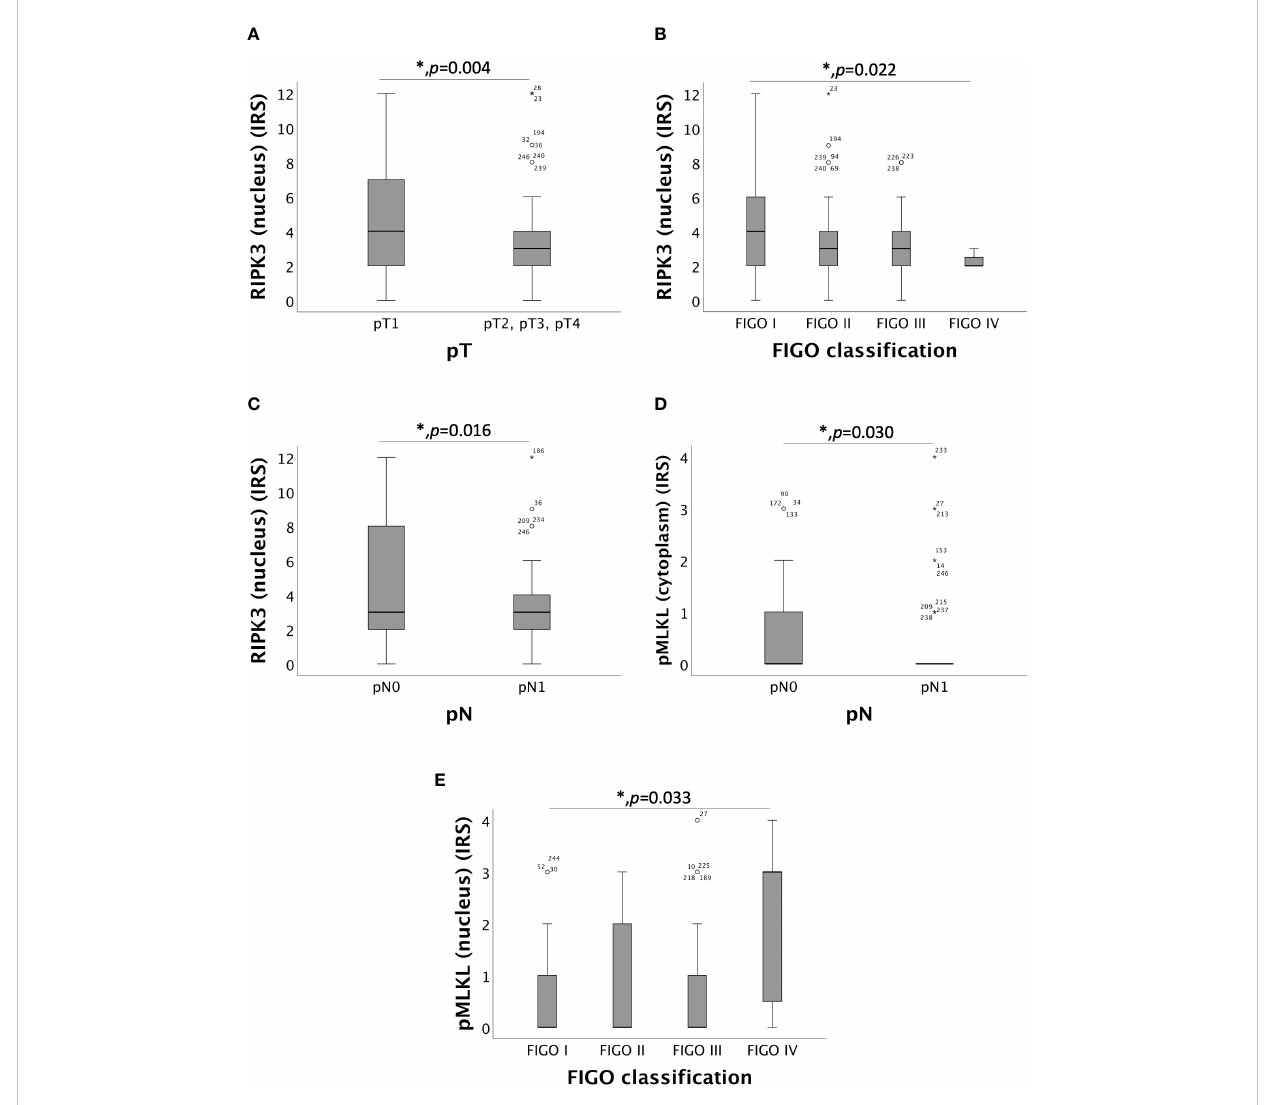
FIGURE 2 Correlation of RIPK3 and pMLKL with pT, pN and FIGO-classi fi cation. (A) boxplot of nuclear RIPK3 expression and the size or the extent of the primary tumor (pT) in cervical carcinoma (p = 0.004), median IRS of nuclear RIPK3 in pT1 was 4 (n = 96) and in pT2, pT3 and pT4 was 3 (n = 130). (B) boxplot of nuclear RIPK3 expression and FIGO classi fi cation in cervical carcinoma (p = 0.022), median IRS of nuclear RIPK3 in FIGO I was 4 (n = 69), in FIGO II was 3 (n = 61), in FIGO III was 3 (n = 89) and in FIGO IV was 2 (n = 7). (C) boxplot of nuclear RIPK3 expression and regional lymph node status (pN) in cervical carcinoma (p = 0.016), median IRS of nuclear RIPK3 expression in pN0 was 3 (n = 133) and in pN1 was 3 (n = 93). (D) boxplot of cytoplasmic pMLKL expression and regional lymph node status (pN) in cervical carcinoma (p = 0.030), median IRS of cytoplasmic pMLKL expression in pN0 was 0 (n = 120) and in pN1 was 0 (n = 87). (E) boxplot of nuclear pMLKL expression and FIGO classi fi cation in cervical carcinoma (p = 0.033), median IRS of nuclear pMLKL in FIGO I was 0 (n = 61), in FIGO II was 0 (n = 58), in FIGO III was 0 (n = 81) and in FIGO IV was 3 (n =